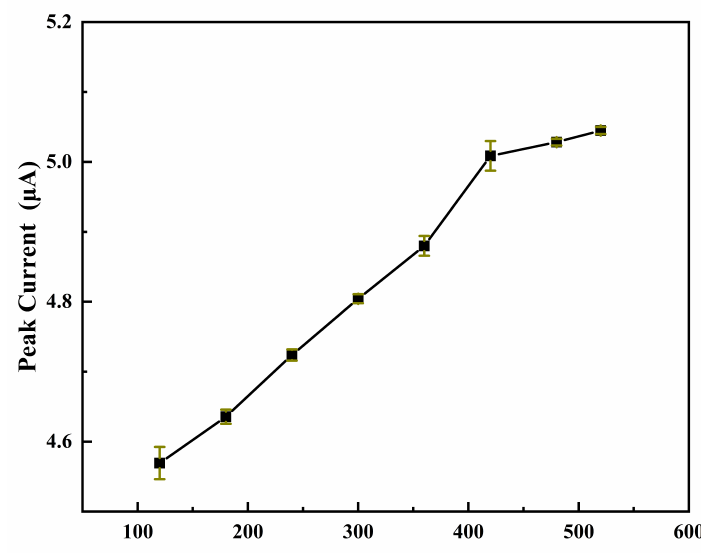
Figure 6. The current peak of Hg 2 + in different deposition time.